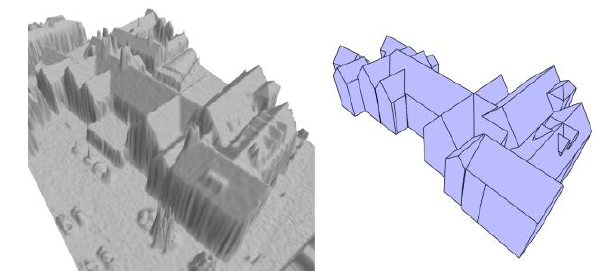
Figure 11. Digital surface model and reconstructed building.